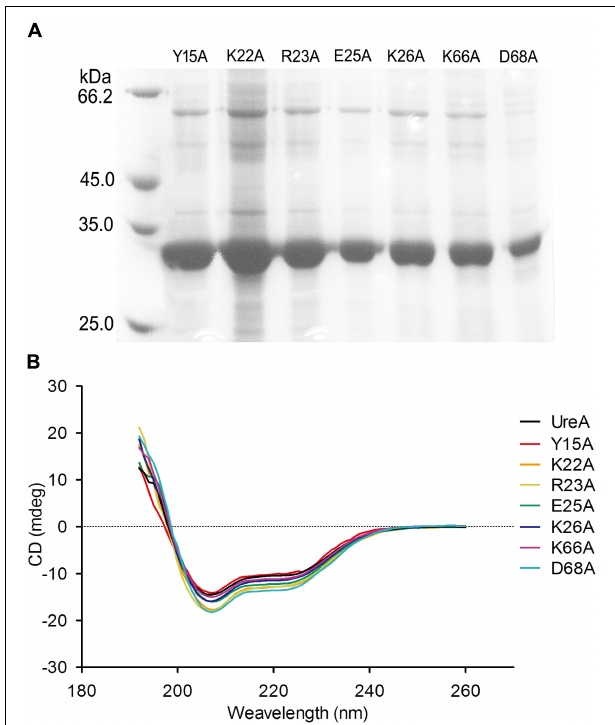
FIGURE 5 | Purification and secondary structural analysis of UreA-His mutants. (A) Seven purified mutants of UreA-His. (B) CD spectra of UreA-His and its mutants. UreA-His mutants were purified in the same procedure as Hsp60, except that the buffer used was changed to PBS (pH 7.4).